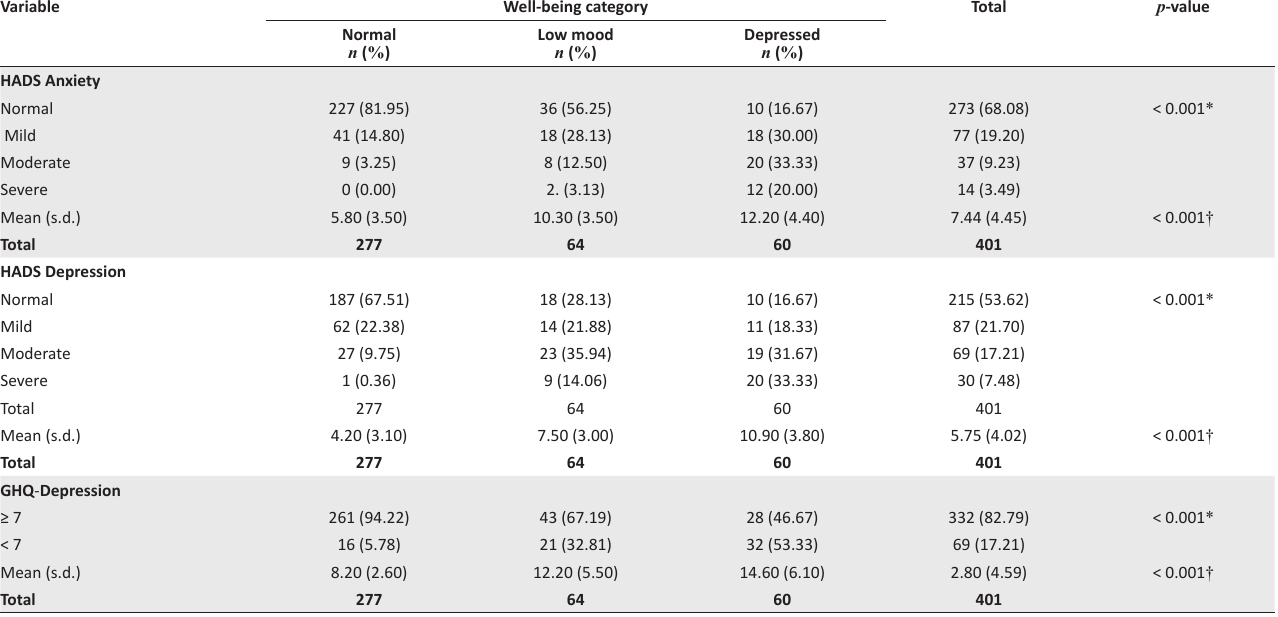
TABLE 5: HADS and GHQ-Depression categories compared to WHO-5 well-being categories. Variable